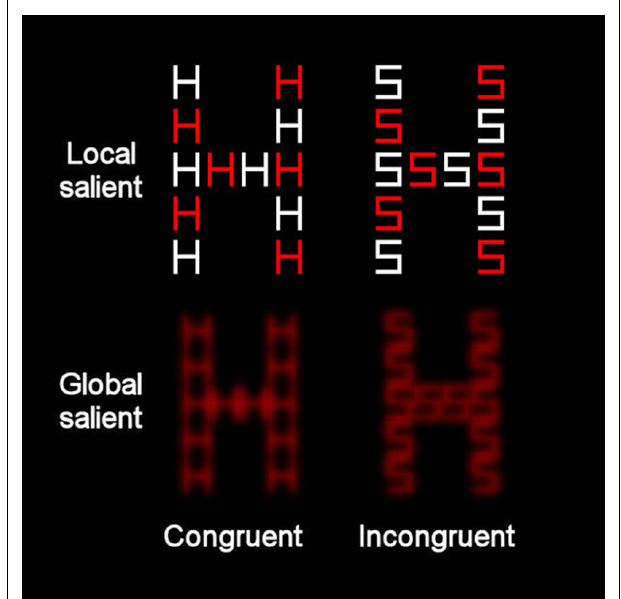
FIGURE 3 | Example of the compound letters that were used in the present study incorporating global-more-salient and local-more- salient displays. The levels of each stimulus could be congruent (where local and global letters matched) or incongruent (where local and global letters